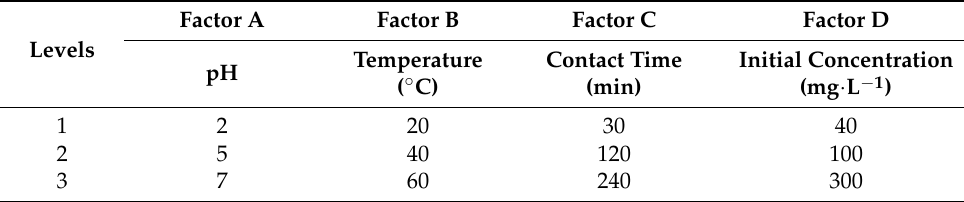
Table 3. List of factors and levels for the orthogonal experimental study.